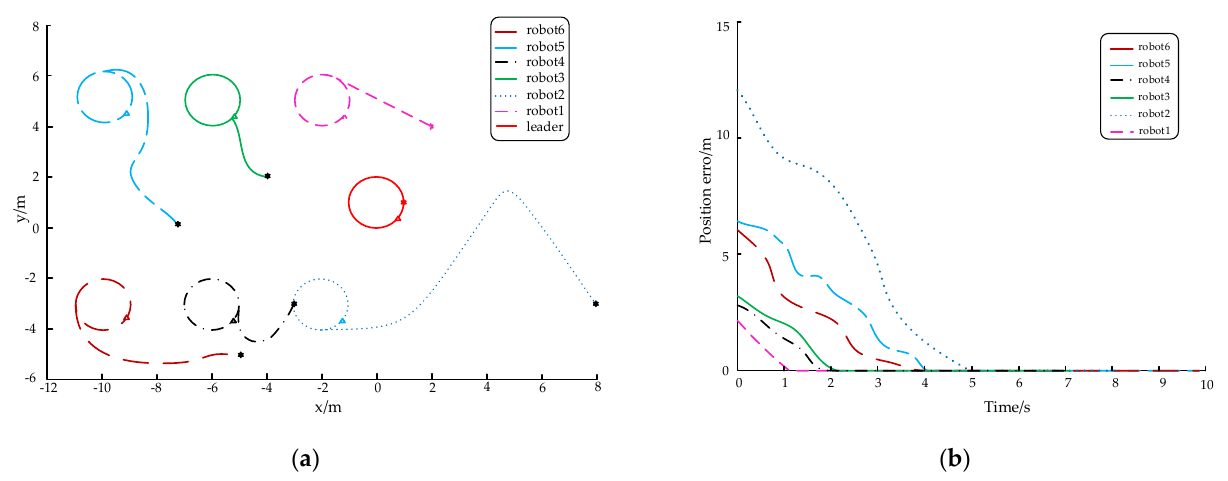
Figure 12. ( a ) Trajectories of multi-robot on the plane by GCF; ( b ) Formation position error of each following robot.